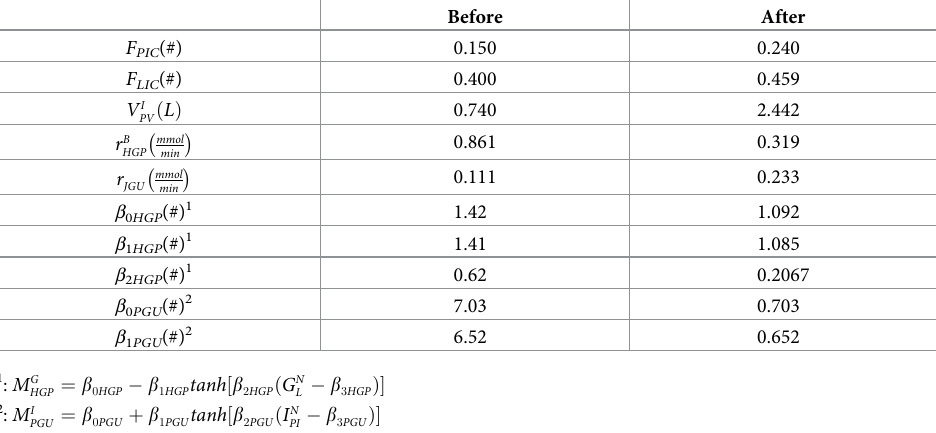
Table 5 (“(before)” and “(after)” columns respectively). In this figure the predictions from the Sorensen model are comparable with those obtained under the Hovorka and UVAPadova Table 5. Results of the set up calibration (trial and error) procedure to make the simulation of the Sorensen model comparable with the simulations of the Hovorka and UVAPadova formulations. Before After